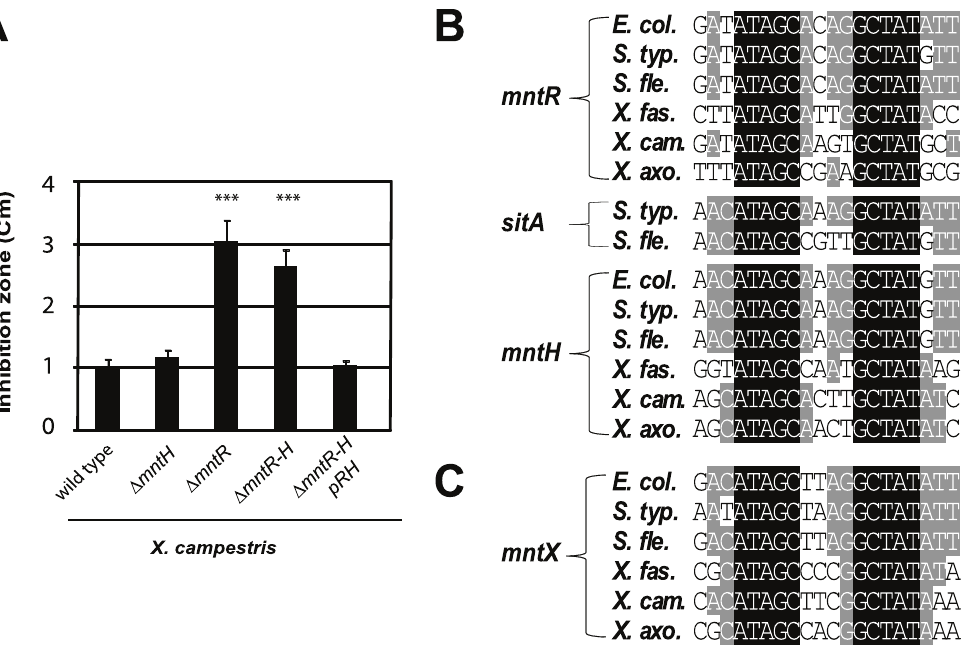
Figure 2. Search for Mn 2 + -regulated bacterial factor(s) in a simple model organism. A) Xanthomonas campestris MntR controls Mn transport: genetic studies of bacterial sensitivity to 1M MnCl 2 , measured by disk assay, revealed a novel Mn resistance factor, as mntR disruption increased Mn sensitivity independent of MntH import (*** p , 0.01 compare to the wild type sensitivity). This experiment done in triplicates is representative of several experiments. B) Multiple sequence alignments of MntR binding sites found in the promoters of genes which contribute to Mn homeostasis ( mntH , mntR, sitA) in c -proteobacterial plant or animal pathogens (respectively Escherichia coli , Salmonella typhimurium , Shigella flexneri and Xylella fastidiosa , X. campestris , X. axonopodis ). C) Sequence alignment of the MntR binding site detected upstream of one gene ( yebN or XCC4075 herein referred to as mntX ), using the PredictRegulon web site, and that is conserved c -proteobacteria.